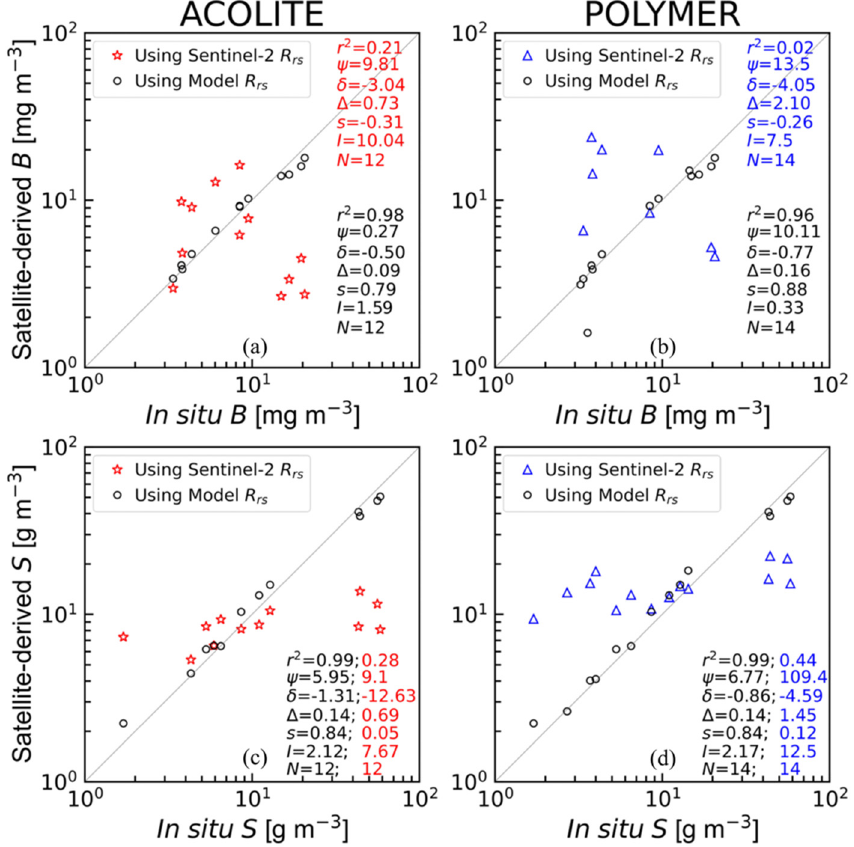
Figure 8. Comparison between the in situ and modelled B ( a , b ) and S ( c , d ) values using ACOLITE (red stars) and POLYMER (blue triangles) reflectance using the satellite matchup dataset ( N = 12 for ACOLITE and N = 14 for POLYMER, Table 1). The black circles show the B and S values using modelled reflectance ( R e ). The derived statistical values in black, blue, and red colours are generated between the in situ and modelled variables ( B and S ) using the modelled ( R e ), and corrected ACOLITE ( 𝜌 (cid:3050)(cid:3002) (cid:4594) ) and POLYMER ( 𝜌 (cid:3050)(cid:3017) (cid:4594) ) reflectance, respectively.